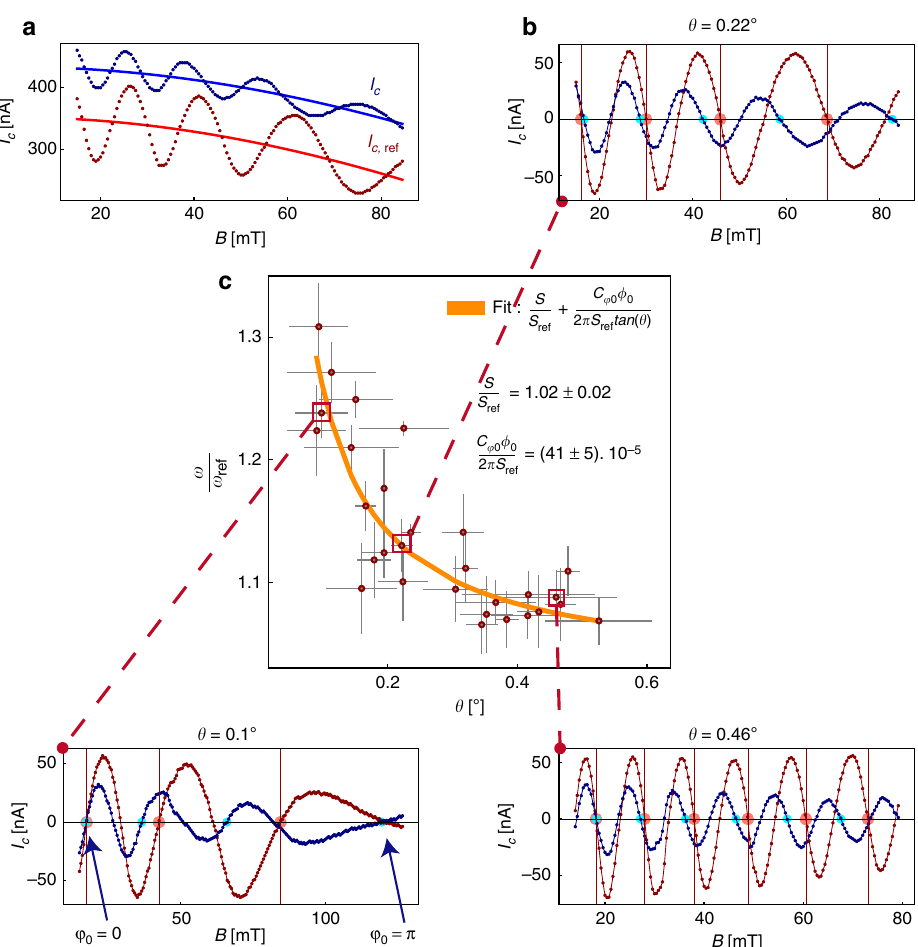
Fig. 5 Comparison of the JIs frequencies as a function of the angle θ . a The critical current is extracted and shown as a function of magnetic fi eld. The red and blue curves correspond to the reference and anomalous device, respectively. As the critical current of the large junction decreases with the magnetic fi eld, this leads to a decreasing background fi tted for both devices and shown by the continuous lines. b Critical current as a function of magnetic fi eld where the background, indicated by continuous lines in panel a , are subtracted. The anomalous device shows a larger oscillation frequency than the reference device. The colored dots help to visualize the increased frequency of the anomalous device (blue dots) with respect to the reference device (red ’ π for dots). The two JIs are in-phase at low magnetic fi eld and become out-of-phase at high magnetic fi eld, with an anomalous phase shift reaching φ 0 B ’ 100 mT . The periods are compared one by one and the average of the single period ratios provides the value ω . c The ratio of the oscillation ω ref frequencies is plotted as a function of the angle θ . Without the generation of an anomalous phase, this ratio should be constant and equal to the surface ’ 1. This ratio diverges as 1 θ , as shown by Eq. (3). Fitting the curve with Eq. (3) provides the spin-orbit coef fi cient ratio S S θ for small ref